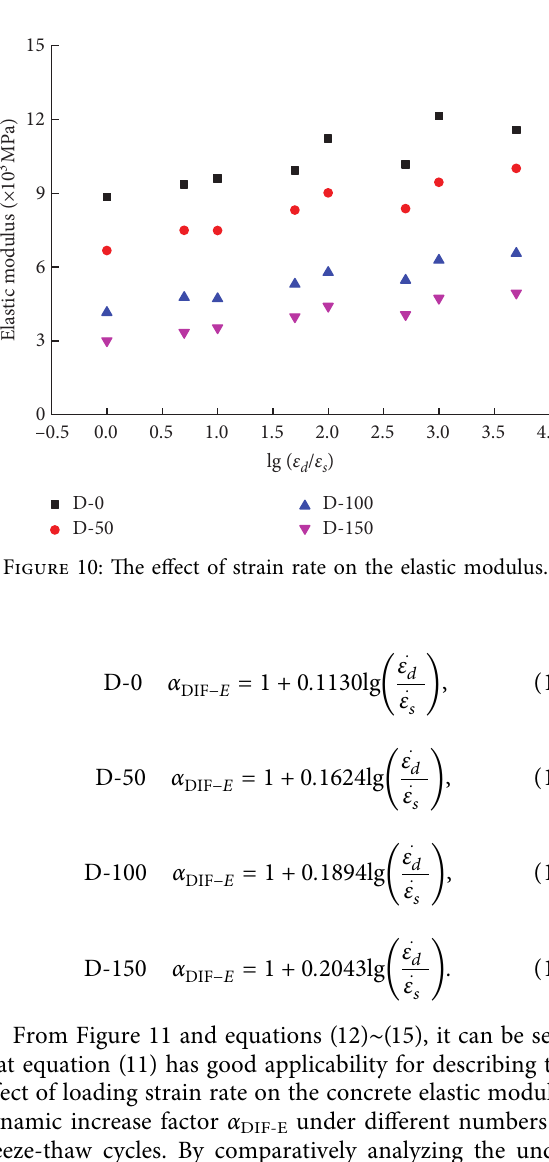
Figure 9: The relationship between the number of freeze-thaw cycles D and parameter a 1 .